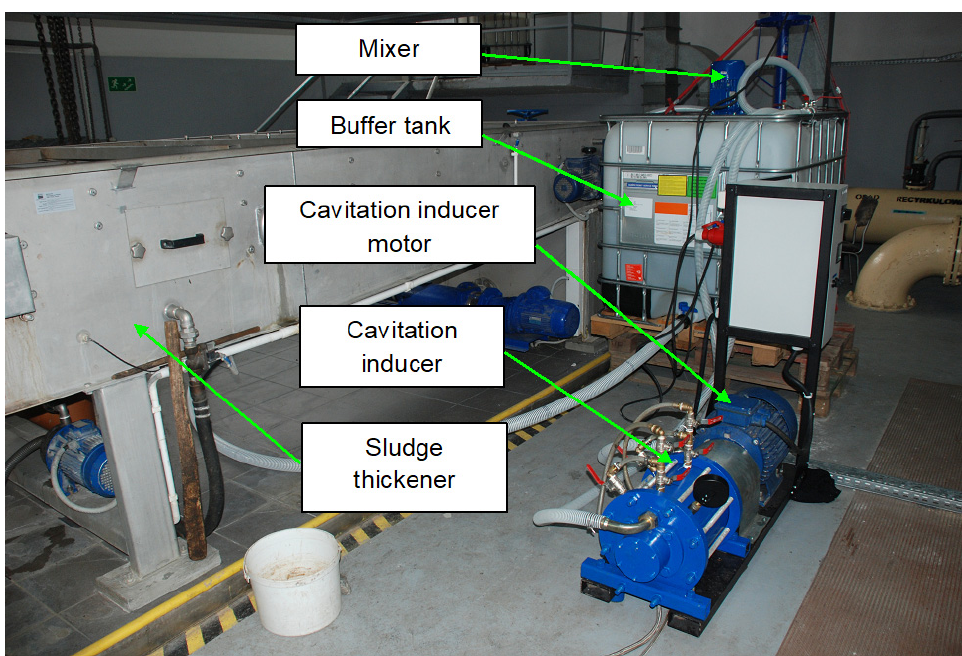
Figure 2. View of a cavitation inducer installed in a wastewater treatment plant.